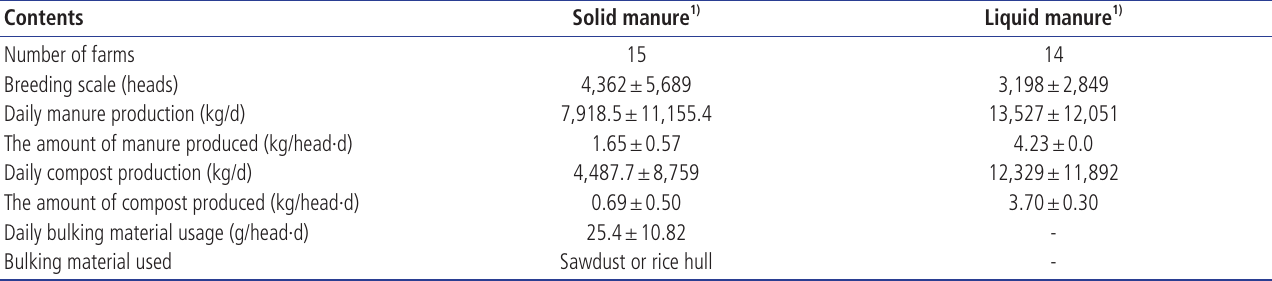
Table 1. Basic information of swine farms